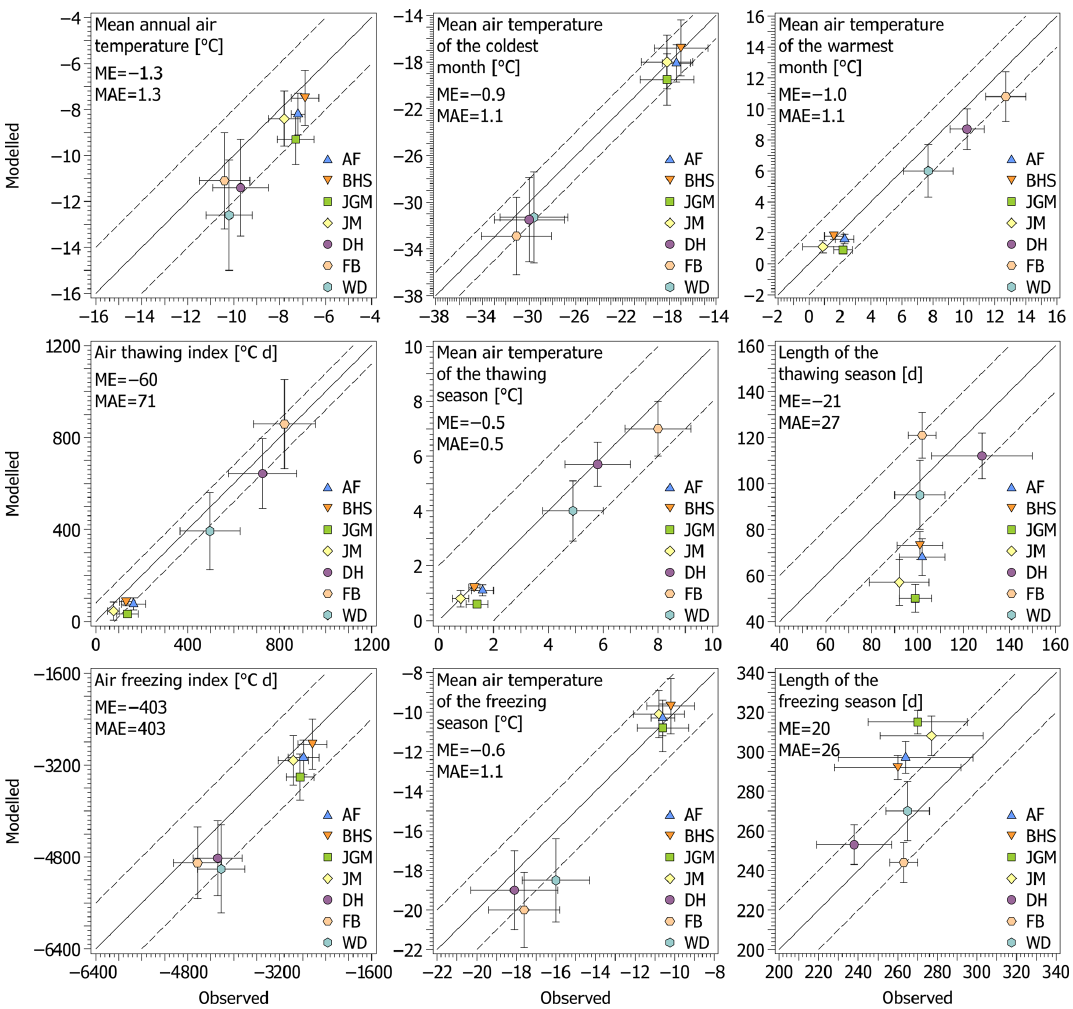
Figure 3. Means and standard deviations of observed and modelled air temperature characteristics at the James Ross Island and Alaskan Arctic validation sites. Acronyms ME and MAE under the plot labels correspond to the site-weighted mean error and the site-weighted mean absolute error, respectively, while those at the bottom right of the plots indicate the names of the validation sites: Abernethy Flats (AF), Berry Hill slopes (BHS), Johann Gregor Mendel (JGM), Johnson Mesa (JM), Deadhorse (DH), Franklin Bluffs (FB), and West Dock